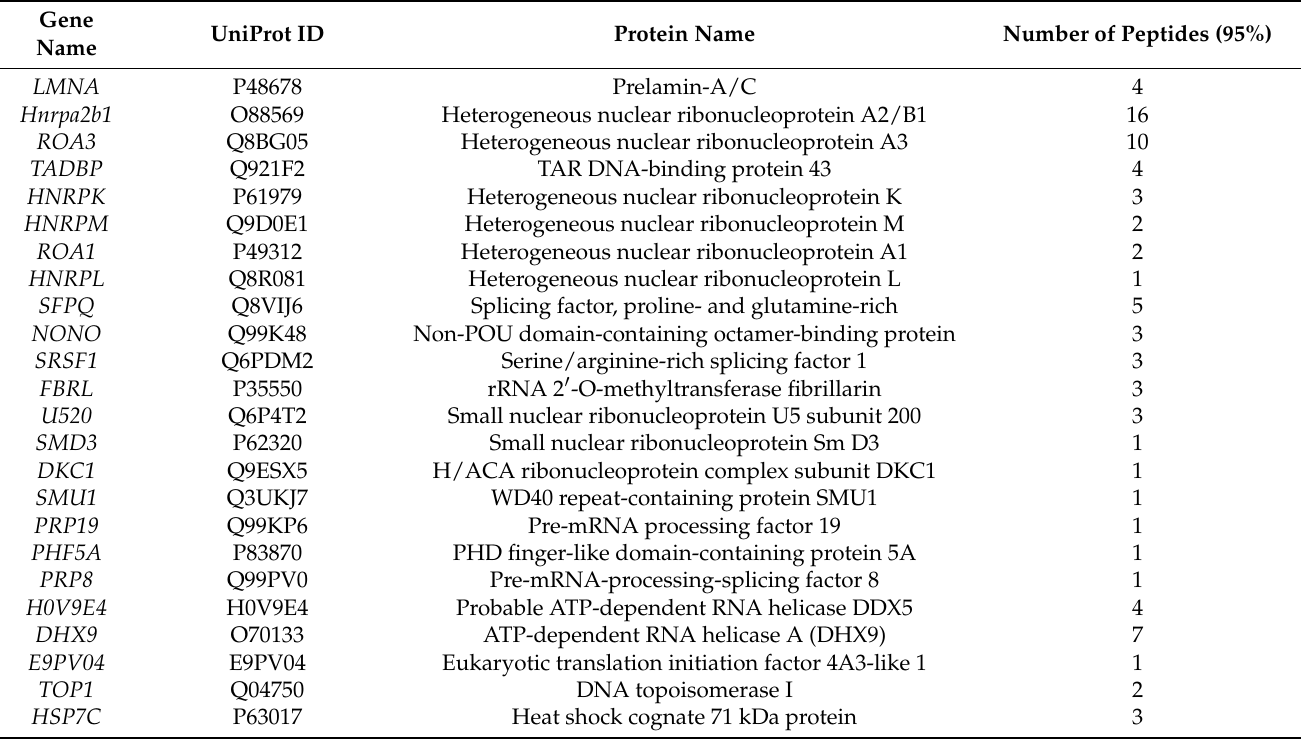
Table 1. Proteins identified in the udTRF2